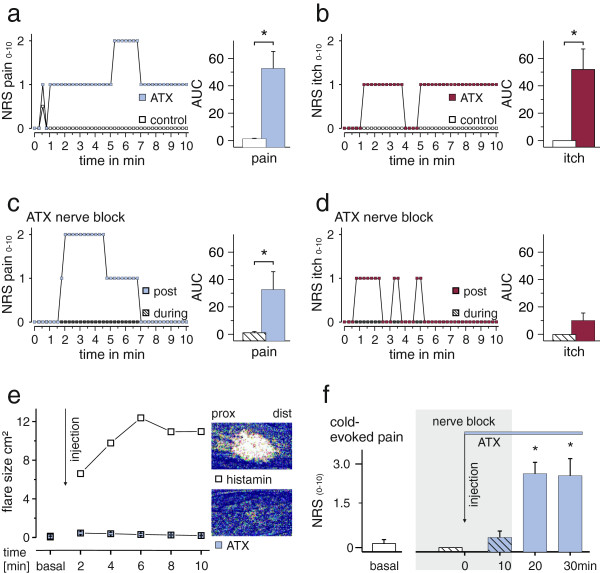
Intradermal injections of ATX-II induces pain and an itch-like sensations in human volunteers. (a) Pain assessment (on a numerical rating scale, NRS 0–10) as a function of time for a subject following injection of saline solution without (control) or with ATX-II. Under control conditions (white symbols) only a short lasting pain is evoked immediately after the injection in agreement with mechanical irritation, whereas ATX-II injection (blue symbols) leads to distinctly augmented ratings. The right panel shows the mean area under the curve (AUC) for n = 6 volunteers (* p < 0.05). (b) Assessment of itch-like sensations on a NRS ranging from 0–10 following injection (sensation rated as 3 is equivalent to desire to scratch) of one representative subject. While under control conditions (white symbols) no itch is induced following injection, ATX-II (red symbols) evoked itch-like sensations, also reflected in a larger AUC (right, * p < 0.05). (c) and (d) Pain (blue squares and bar) and itch (red squares and bar) ratings as a function of time following compression induced nerve block. After 30–40 min of A-fiber block ATX-II was injected and sensations were rated during 10 min (hatched squares). While no pain and itch is evoked by ATX-II under nerve block conditions, pain (blue symbols) and itch (red symbols) recur fast after removal of the block. AUCs of pain ratings increased significantly after removal of the block (* p < 0.05). (e) Area of increased blood flow measured by laser doppler imaging every 2 min following ATX-II injection (blue squares, n = 6) shows hardly any increase in superficial blood flow. For comparison, a typical histamine-induced axon reflex erythema mediated by activation of C-fibers and concomitant CGRP release is shown (white squares). Right: Example images taken 4 min after application of substances. (f) Assessment of cold-evoked (0°C, 7 s) pain (NRS 0–10) before (white bar) and during nerve block (hatched bars). 10 min after injection of ATX-II cold-evoked pain is rated and the nerve block removed. Cold-evoked pain 20 and 30 min after injection of ATX-II significantly increases following removal of the nerve block (* p < 0.05).